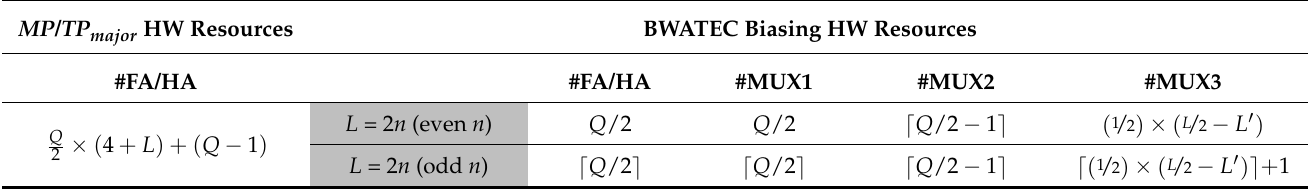
Table 4. HW resources usage of a general L -bit FWBM for various L (cid:48) -bit inputs using the BWATEC scheme ( Q = L /2). MP / TP major HW